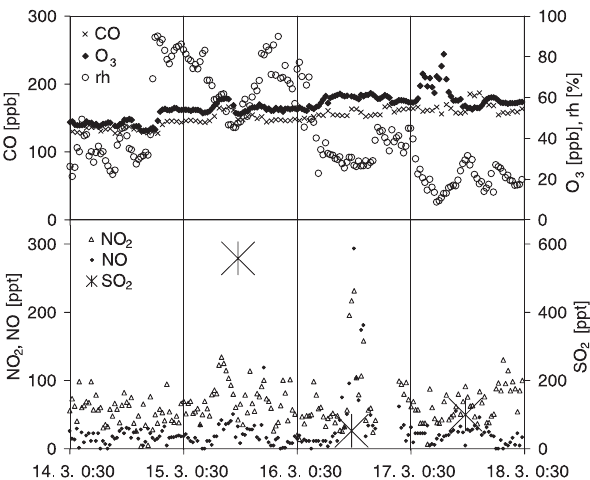
Fig. 5. Measurements of ozone, NO, NO x , SO 2 , CO, and relative humidity at Jungfraujoch from 14 to 17 March 1999. Note that SO 2 data are daily average